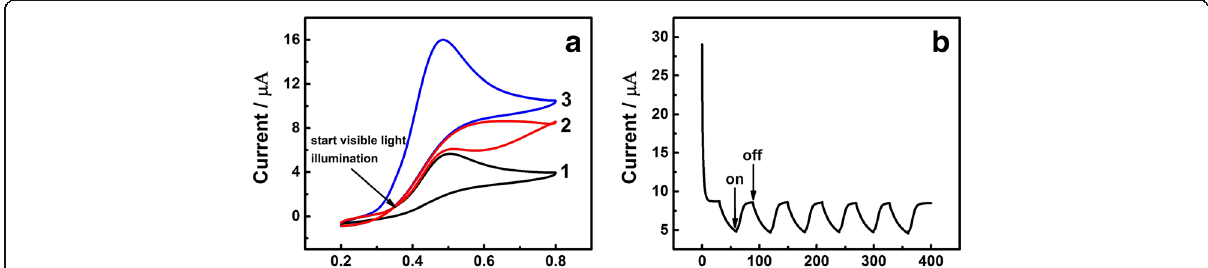
Fig. 3 a Potential/V vs.SCE. The CV of Au/GCE in 0.1 M PBS (pH 7.0) solution containing 1.0 mM UA without (1) and with (3) visible light illumination; visible light illumination starts from the spot where the arrow is pointing (2) . Scan rate 50 mV s − 1 . b Time/s. Photocurrent response of Au/GCE under